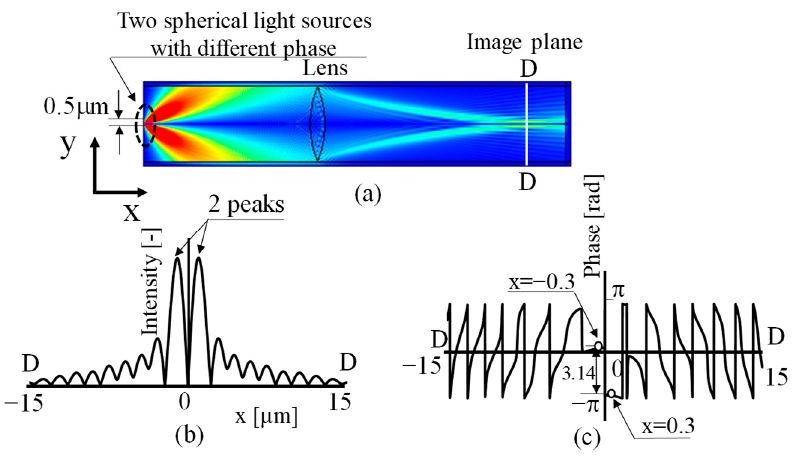
Figure 7. Simulated results when two light sources whose initial phases are different as π rad are set closer (0.5 µ m) than the Rayleigh criterion. ( a ) Electromagnetic field simulation result. ( b ) Intensity distribution in section D-D. ( c ) Phase distribution in section D-D.